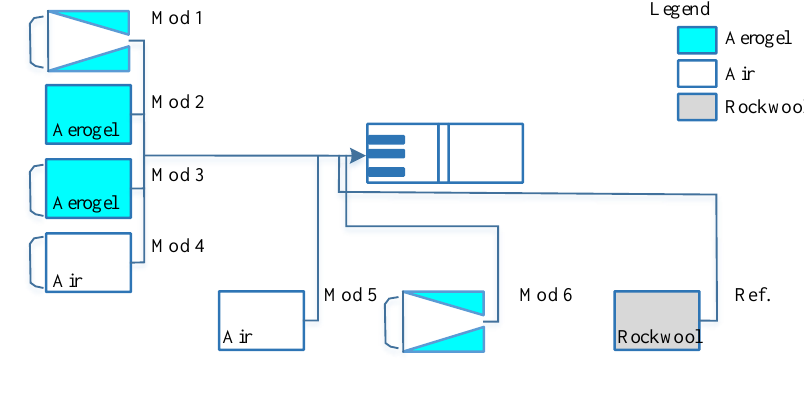
Fig. 2. Solar wall module